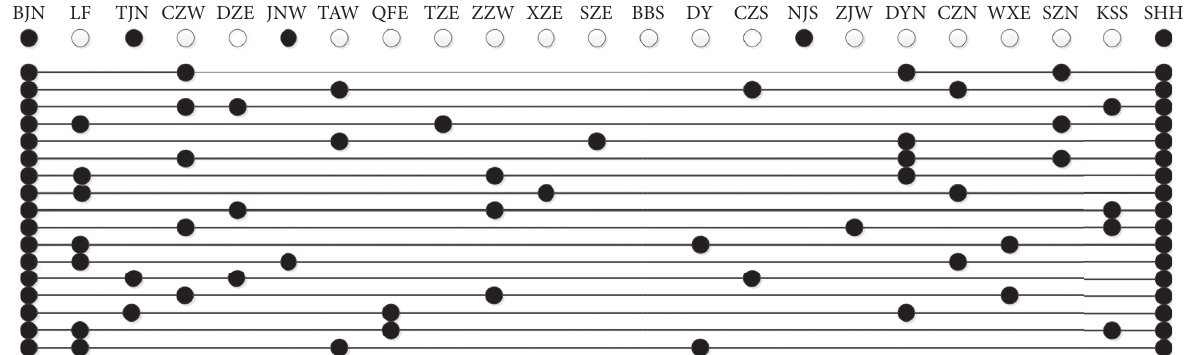
Figure 6: The stop schedule for BJN-SHH with 3 stops.